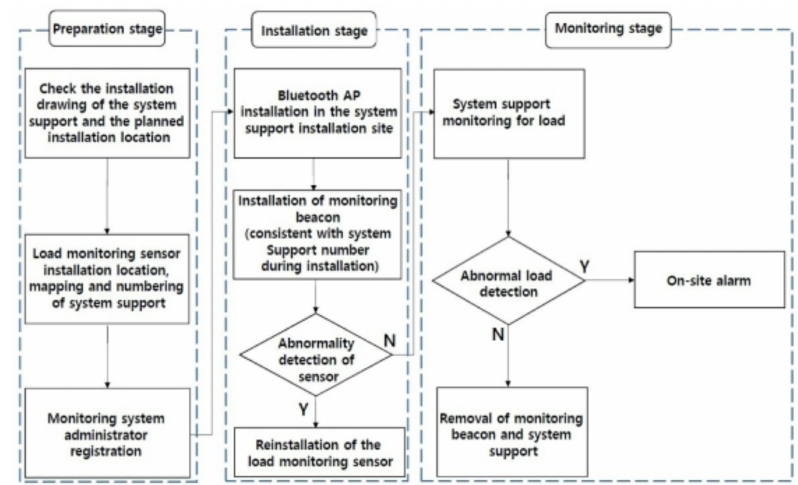
Figure 2. System support monitoring